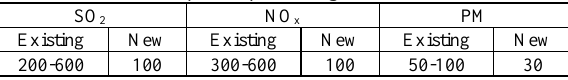
Table 3: Standard emission limits for existing and new thermal